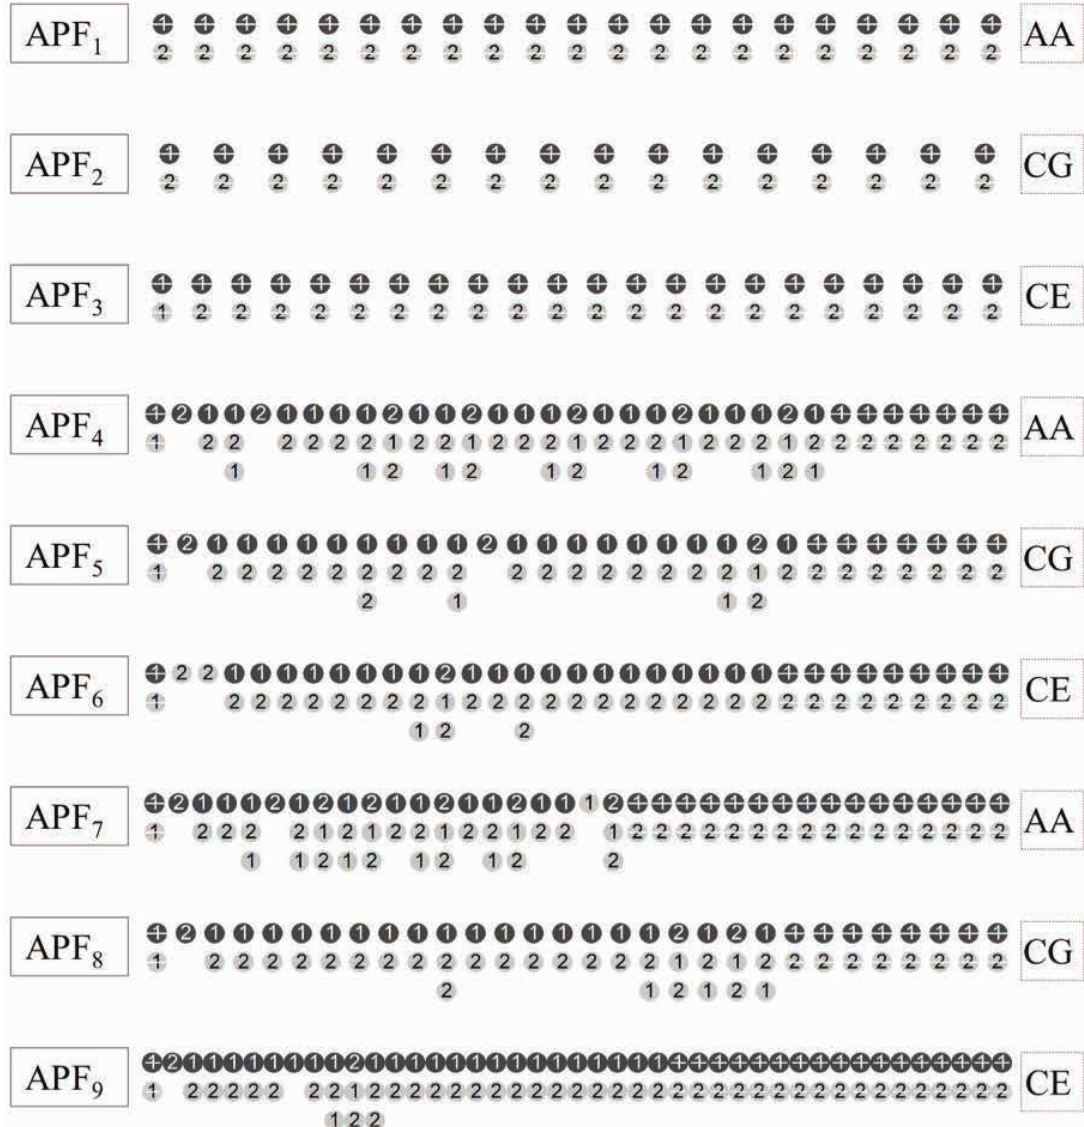
Figure 8: Meter-music relation in the nine turns (APF) of the tema section of the contest. Dark gray circles correspond to MPa and light gray circles correspond to MPb. Numbers 1 and 2 inside the circles correspond to the HL dard circles (i.e. circles with no horizontal bar) correspond to lines based on AMS, i.e. the metrical scheme of the arrepentina proper, whereas barred circles correspond to lines construed on the currentina scheme (see Fig. 2